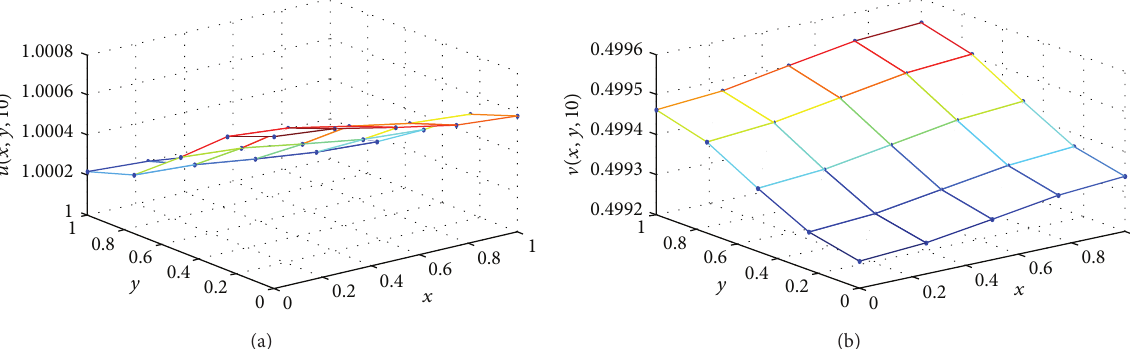
Figure 4: The approximate solutions profiles of 𝑢 and V for the Brusselator model at 𝑡 = 10 obtained by using Crank-Nicolson method: 𝑚 = 10 , 𝑁 = 25 , and Δ𝑡 = 0.1 . (a) 𝑢 at 𝑡 = 10 ; (b) V at 𝑡 = 10